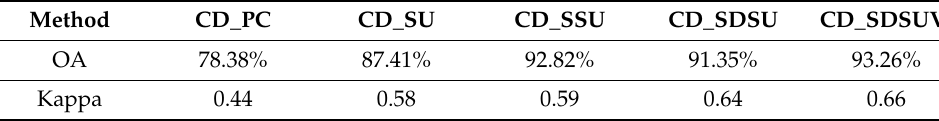
Figure 9. The change detection results of real data 1: ( a ) reference image, ( b ) CD_PC, ( c ) CD_SU, ( d ) CD_SSU, ( e ) CD_SDSU and ( f ) CD_SDSUVE. Table 5. The accuracy statistics for real data